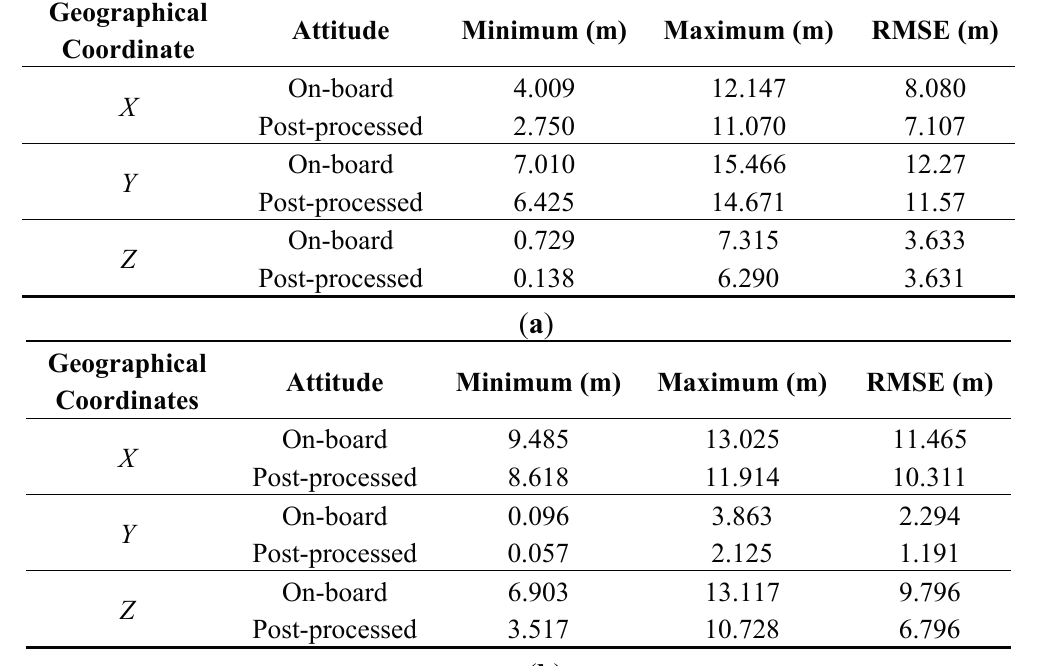
Table 4. Position accuracy comparison without using GCPs (in the Earth-centered system). ( a ) Positioning accuracy comparison without using GCPs in the Taihang Mountain region (the 457th track); ( b ) Positioning accuracy comparison without using GCPs in the Tianjin area (the 785th